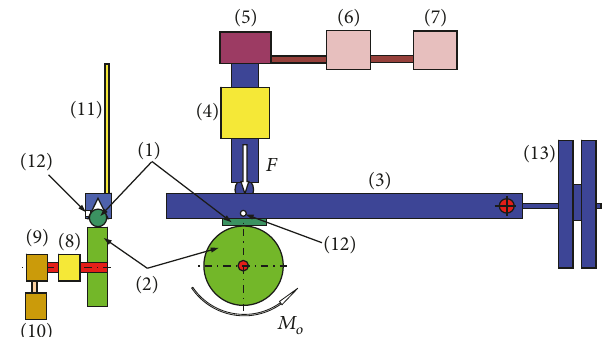
Figure1:Layoutofthetribometerusedinthetests: (1) specimen, (2) counterspecimen, (3) specimen holder, (4) force sensor, (5) pneu- matic cylinder, (6) pneumatic transducer and pressure regulator, (7) compressor, (8) torquemeter, (9) electric motor, (10) frequency con- verter, (11) movement sensor, (12) thermocouple for temperature measurements of the specimen, and (13) counterweight.